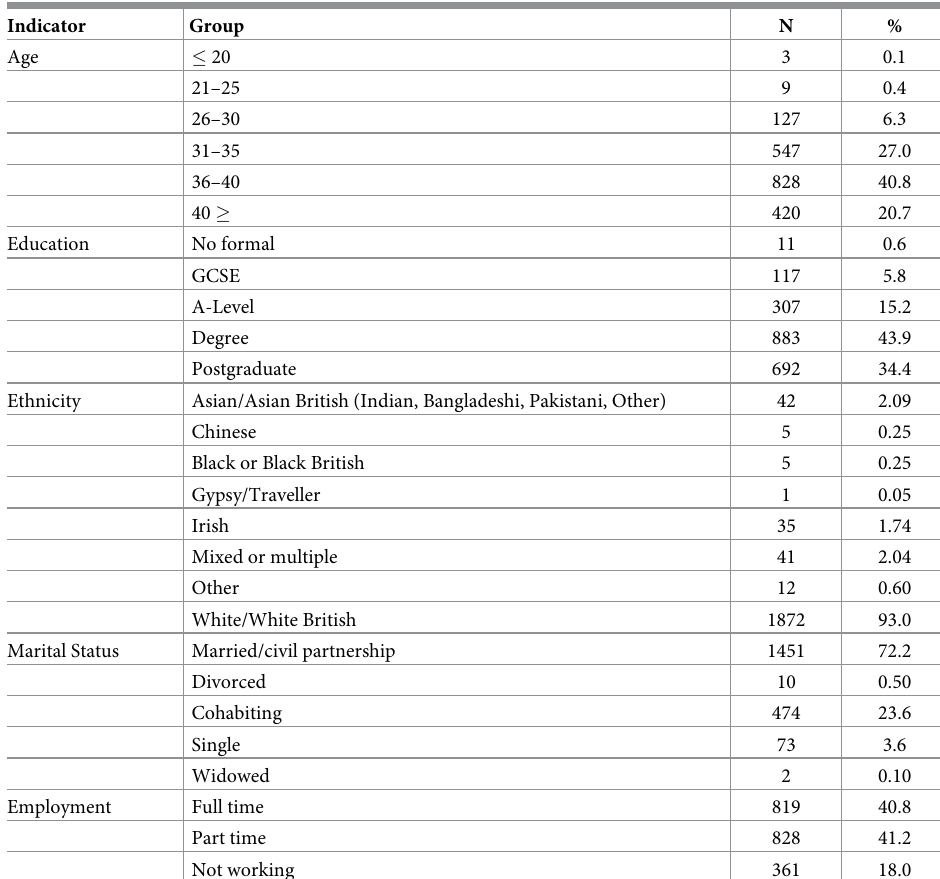
Table 1. Sample distribution by demographic